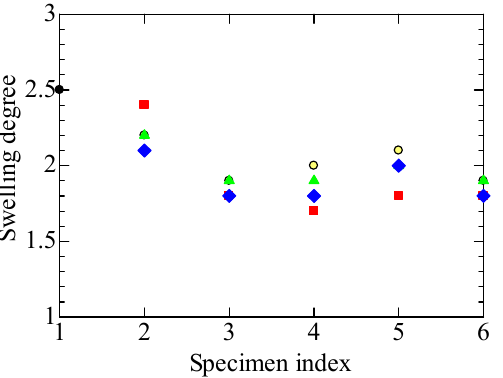
Figure 10. Changes in the degree of swelling at each stage for various tubular specimens. Refer to Tables 1 and 2 and Figure 4 for the meanings of the numerals on the abscissa and sample symbols. Several data may overlap each other.